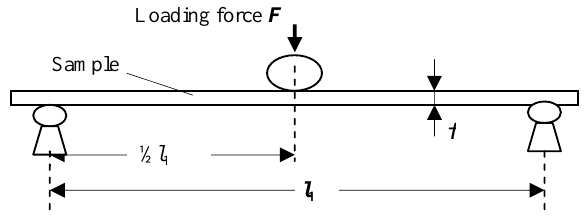
Fig. 3. Schematic representation of bending experiment